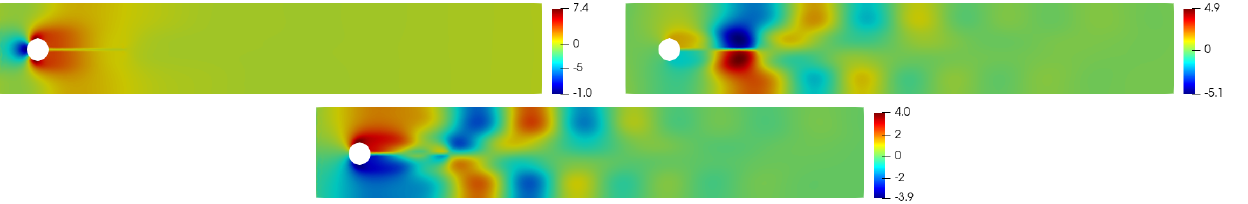
Figure 16. The first three POD modes for the Poisson recovery of the fluid pressure p f .